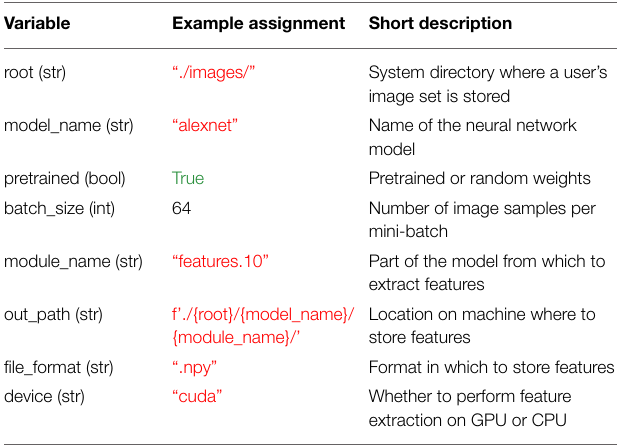
TABLE 1 | Overview of the variables that are relevant for THINGSvision ’s feature extraction pipeline and that facilitate a user’s workflow.